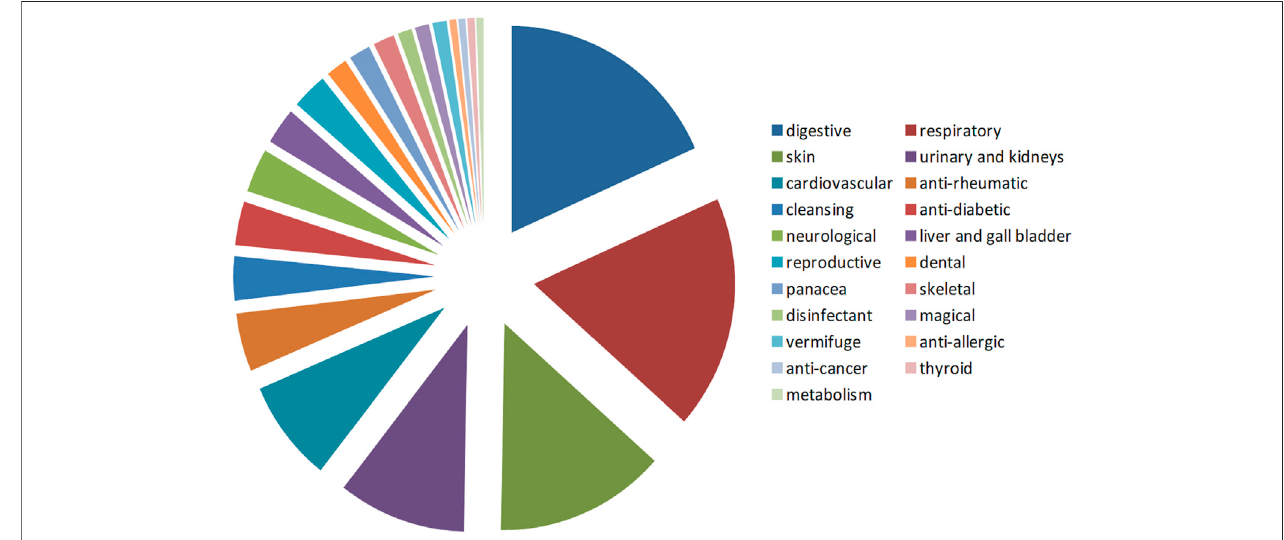
FIGURE 2 | Distribution of ailments treated vs. plant species used.